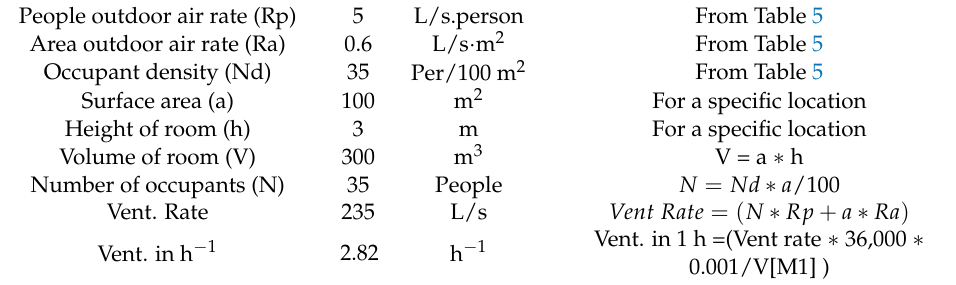
Table 6. Example of ventilation rate computation for the case of a classroom.